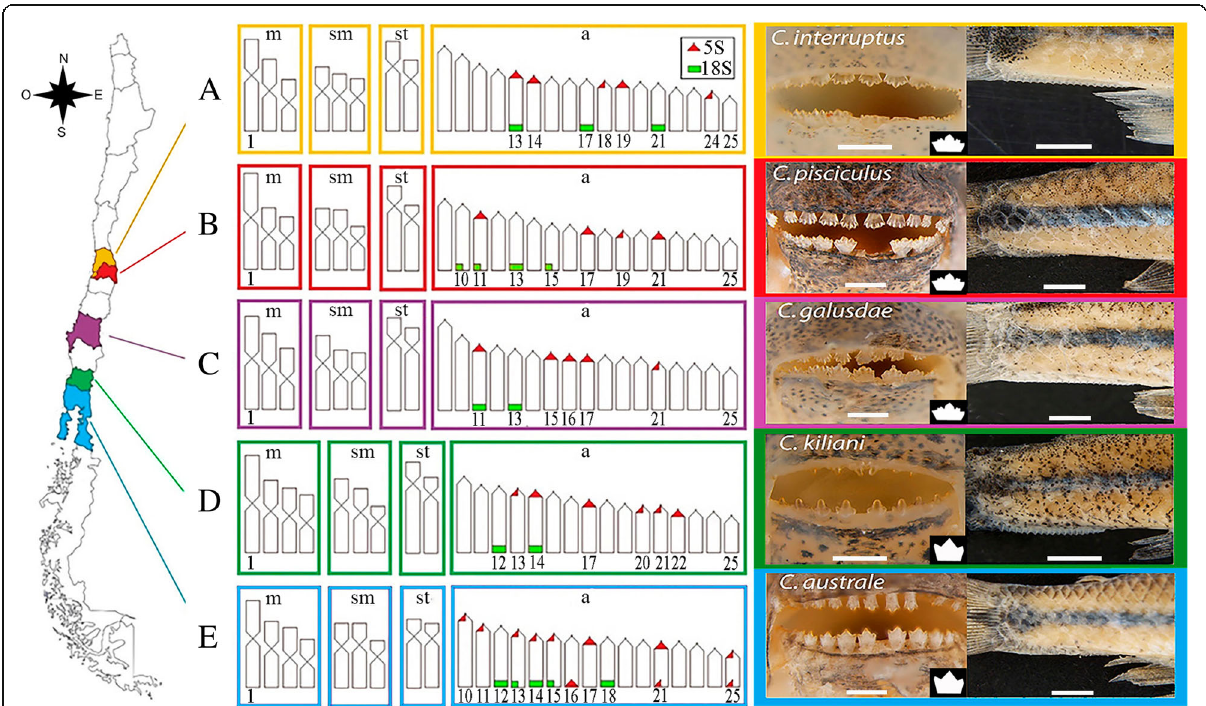
Fig. 4 Geographic regions of Chile (left), ideograms (middle) and photographs of teeth and caudal peduncle region (right) of Cheirodon species occurring in Chile. ( a ) Ch. interruptus from Estero Marga-Marga; V region, ( b ) Ch. pisciculus from Angostura River; Metropolitan region, ( c ) Ch. galusdae from Andalién River; VIII region, ( d ) Ch. kiliani from Calle-Calle River; XIV region and ( e ) Ch. australe from La Poza Lake; X region, base level Llanquihue Lake. Ideograms show 18S and 5S rDNA gene location. Mid-marks represent rDNA sites that may be present or absent, in the same individual (heteromorphism) or in different individuals (polymorphism). In the photographs of teeth bar: 500 μ m, and in those of peduncle region bar: 2 mm